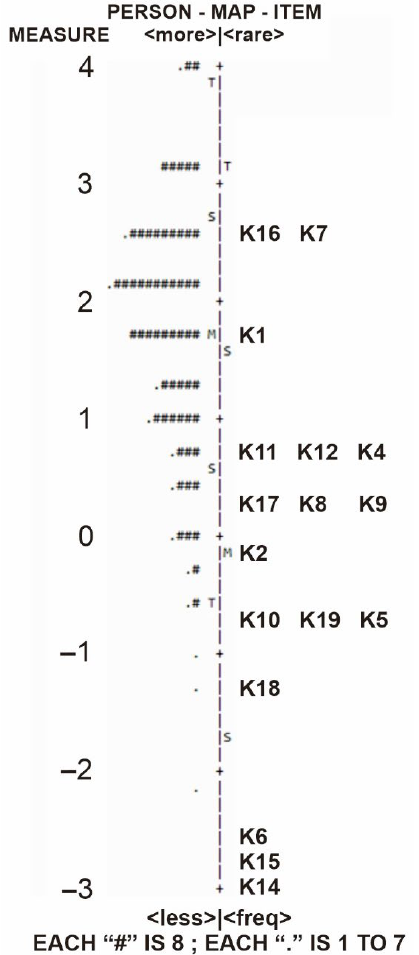
Figure 4. Differential item functioning based on sex. 4. Discussion This study used the dichotomous model of Rasch analysis to examine the psycho- metric properties of structural validity, internal consistency, and measurement invariance for the following core items of the KATUB-Q: general knowledge, transmission, and treat- ment for TB. Based on the results, all items except for a single misfitting item exhibited a unidimensional structure. Considering that a total score is only appropriate when a con- struct to be measured is unidimensional or a subscale [31], the structural validity result pro- vides an empirical rationale for summing all the scores for the core items of KATUB-Q. The person–item map visually displays how the distribution of item difficulty is matched to the ability of a person [20]. Based on the results, the distribution width for the abilities of persons was not well matched with that of the item difficulties. Specifically, there were no items aligned with about half of the people exhibiting the widest range of abilities, implying that the instrument does not contain sufficiently difficult items.